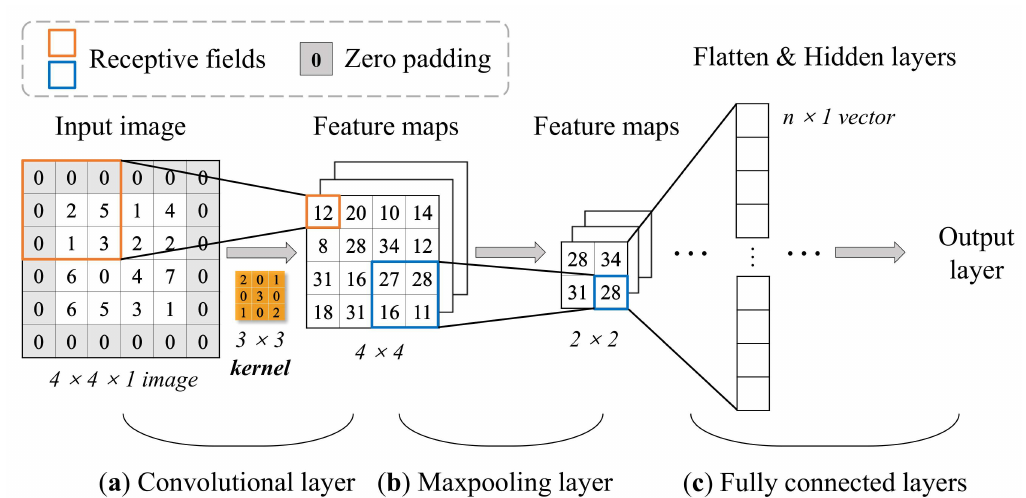
Figure 7. Computation process of an example architecture of 2D CNN with 3 × 3 kernel (it should be noted that the process of bias and activation functions is ignored here for simple illustration). ( a ) Convolutional operation of the input image. The value in the receptive field is multiplied by the value of the corresponding center symmetric position in the kernel and then obtain the summed value in the feature maps. ( b ) 2 × 2 max-pooling process. Each 2 × 2 block is replaced by the maximum value in the receptive field. ( c ) Flatten last feature maps to one-dimension vector for